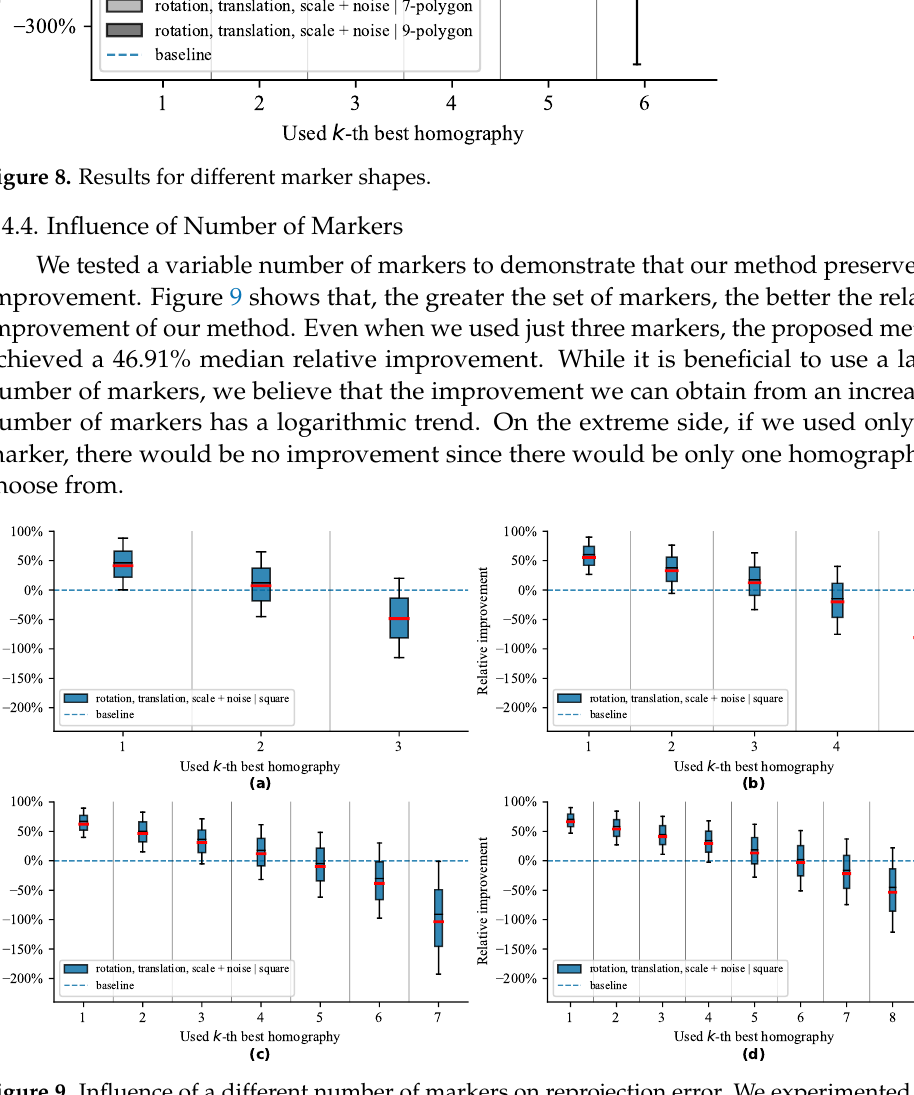
Figure 9. Influence of a different number of markers on reprojection error. We experimented with ( a ) three, ( b ) five, ( c ) seven, and ( d ) nine